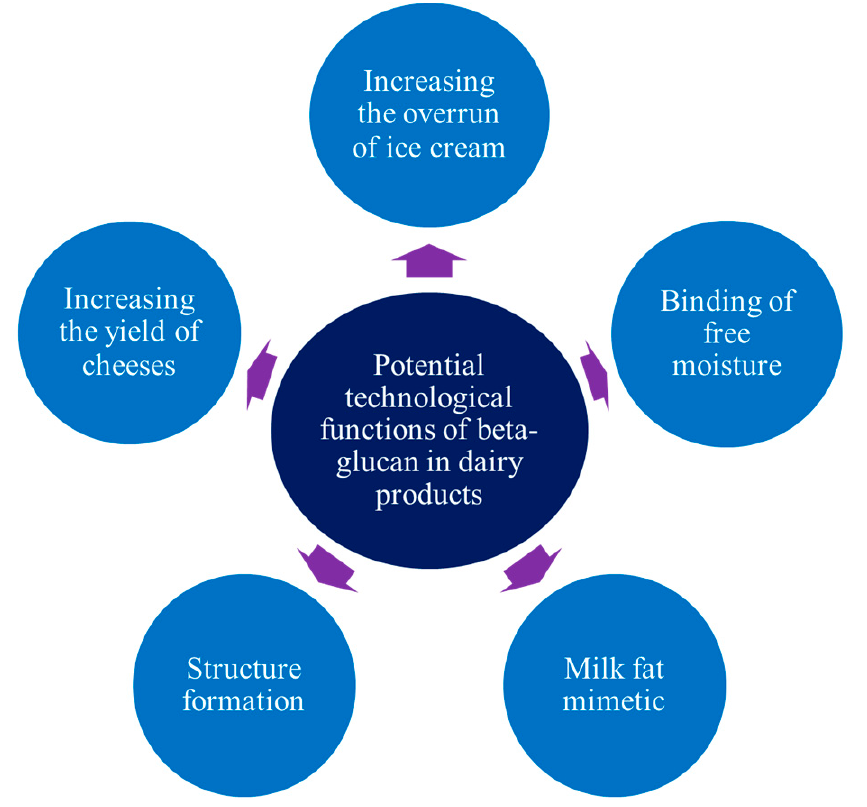
Figure 3. Technological properties of the β -glucan of different types .